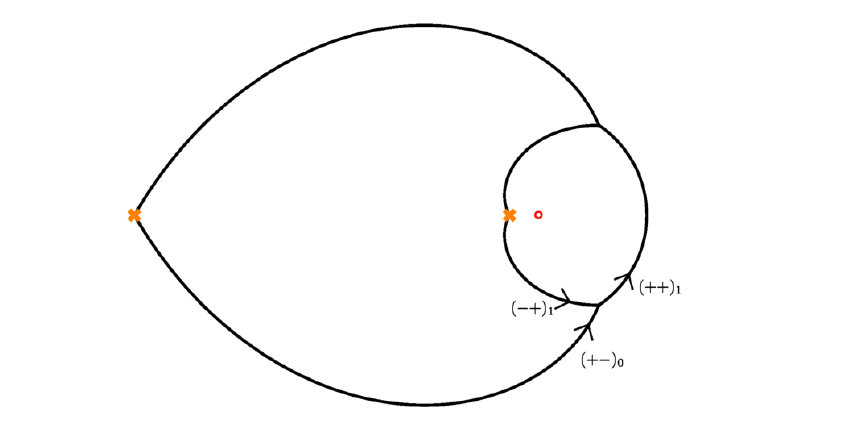
Figure 22. The D0 brane (1 ; 1) at j Q j < 1.